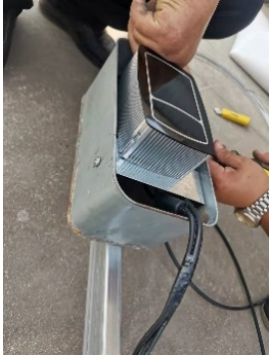
Figure 16. Solid-state lidar.